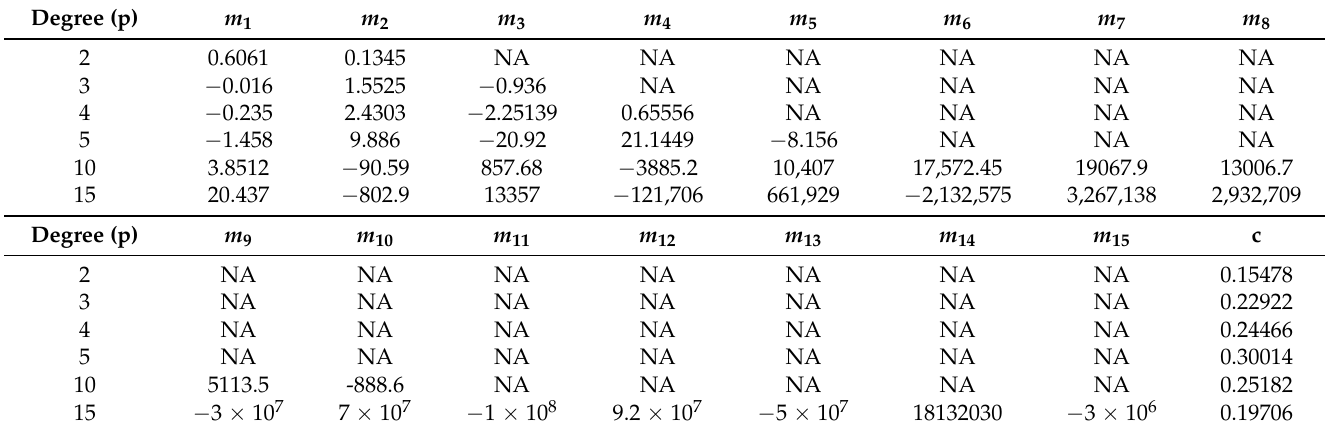
Table 9. PR: coefficients and intercept information.